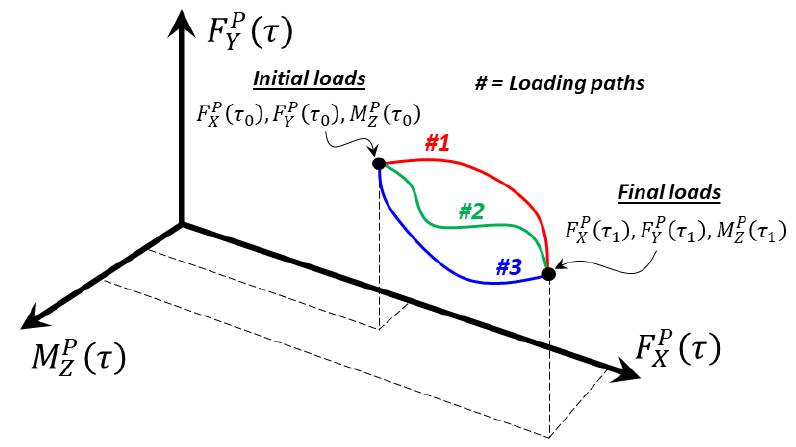
Figure 5. Generic loading paths.